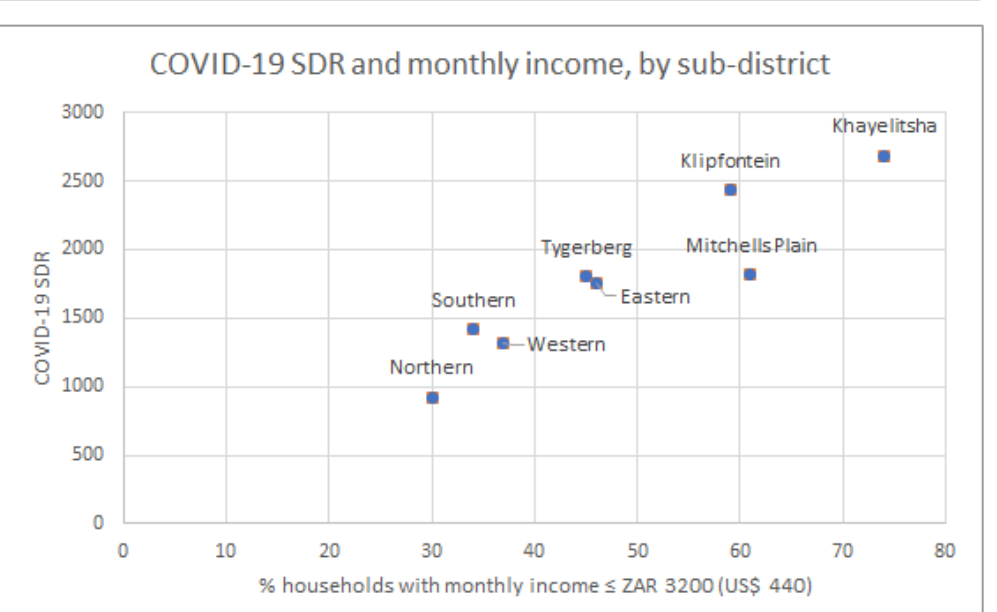
COVID-19 deaths and an overall higher SDR (Figure 5 and Figure